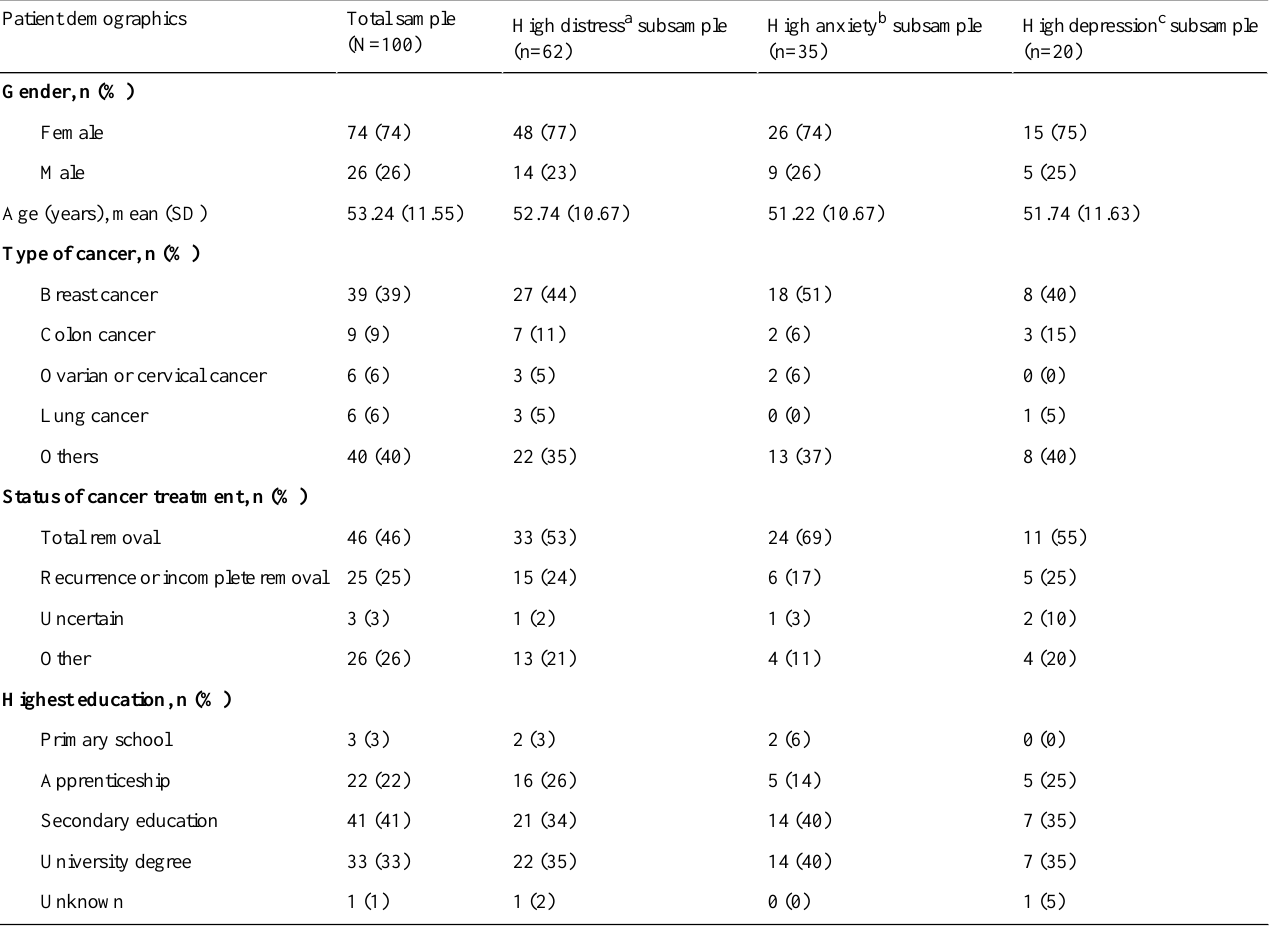
Table 1. Demographics for the total sample and high distress, high depression, and high anxiety